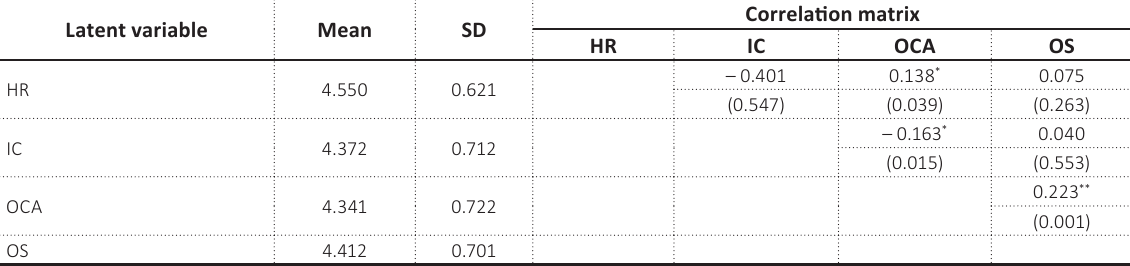
Table 5. Descriptive statistics and correlation